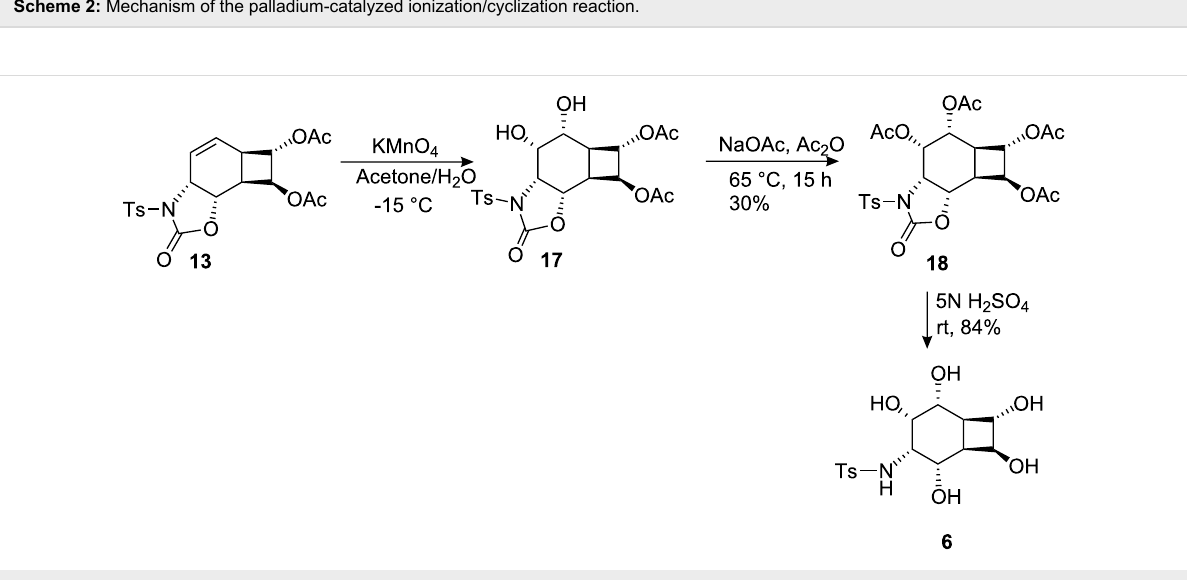
Scheme 2: Mechanism of the palladium-catalyzed ionization/cyclization reaction.